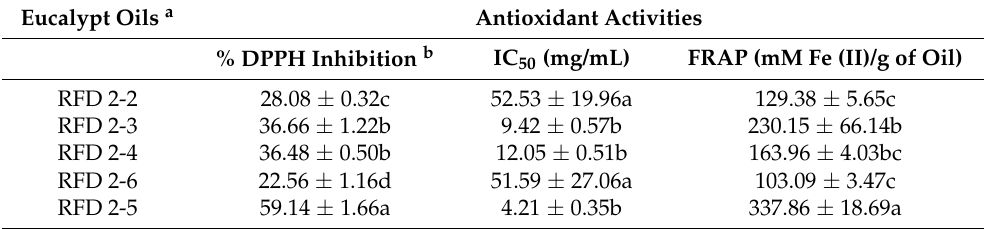
Table 5. Antioxidant activities of the five eucalypt